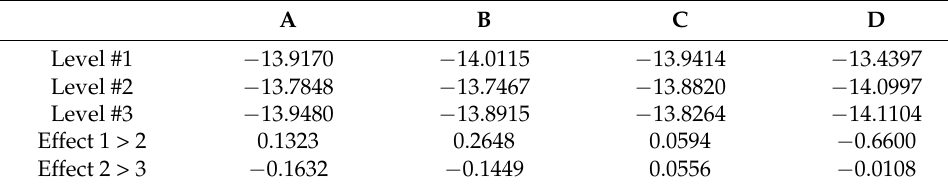
Table 6. Concave factor/level response.